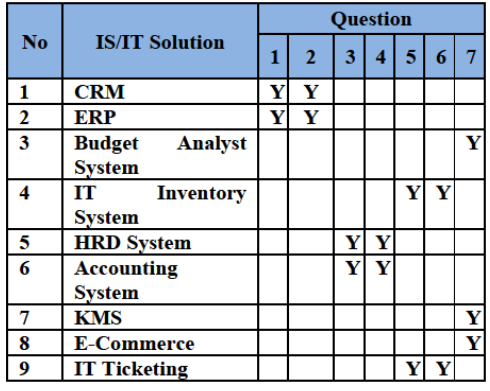
Figure 15: Answer for Question of Quadran